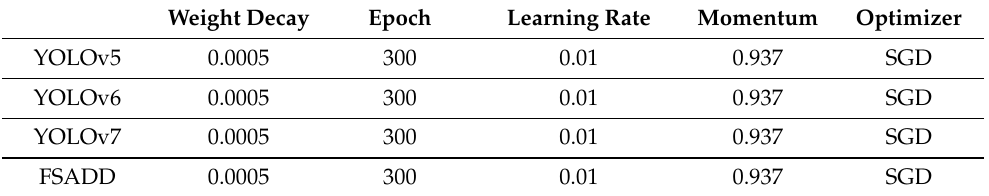
Table 3. Hyper parameter selections for YOLOv5, YOLOv6, YOLOv7, and FSADD. Weight Decay